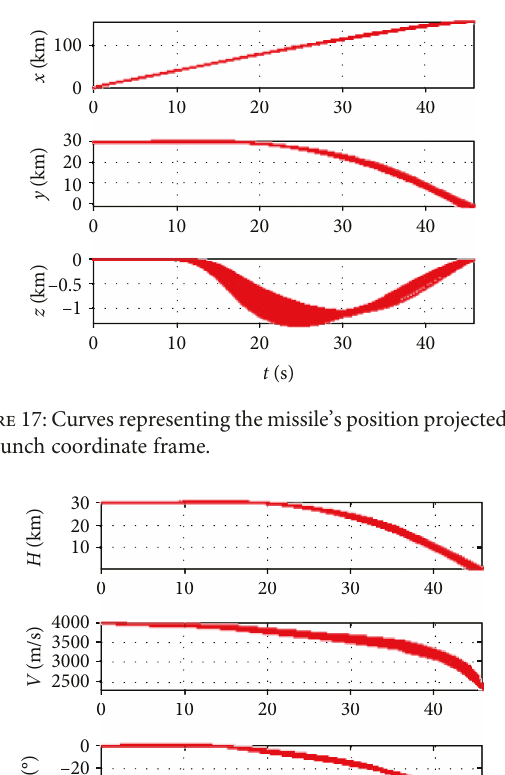
Figure 16: 3D trajectory curve in the dive phase.